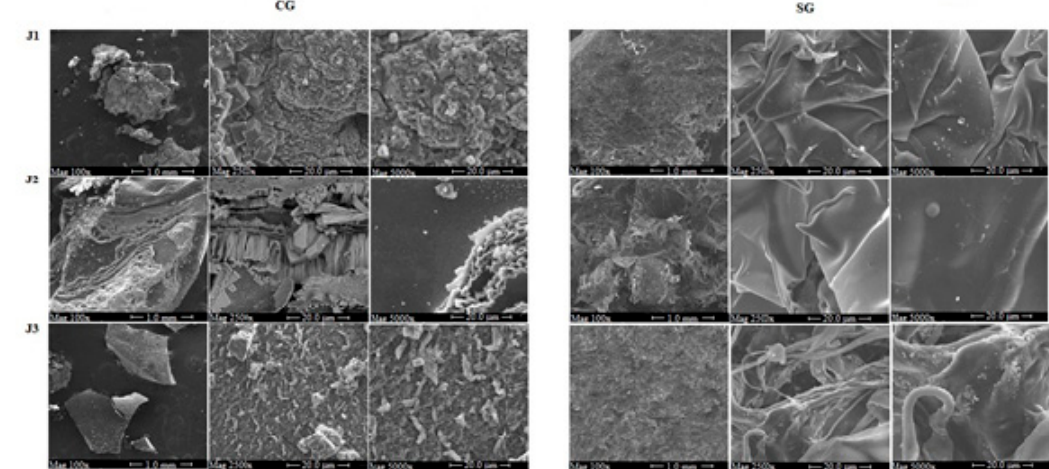
Figure 5. Scanning electron microscopy of crude (CG) and soluble glucans (SG) from J1 (jujubes of first harvesting), J2 (jujube of the second harvesting); J3 (jujube of the third harvesting).